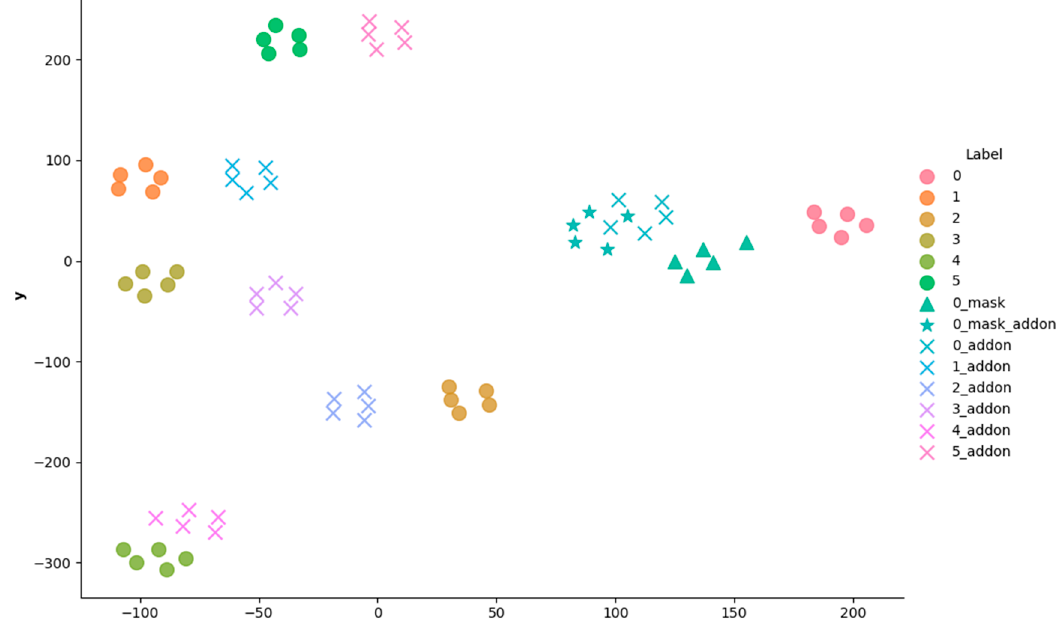
Figure 8. Visualized feature plane. In the label, the number means the class, “_mask” means the composite of the virtual mask, and “_addon” refers to a partial image feature that applies the add-on.